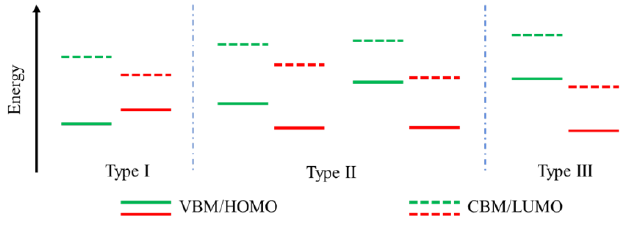
Figure 2. Schematic of type I, type II, and type III arrangements of heterostructures. Table 1. The types of vdWHs arrangement mentioned in the review.